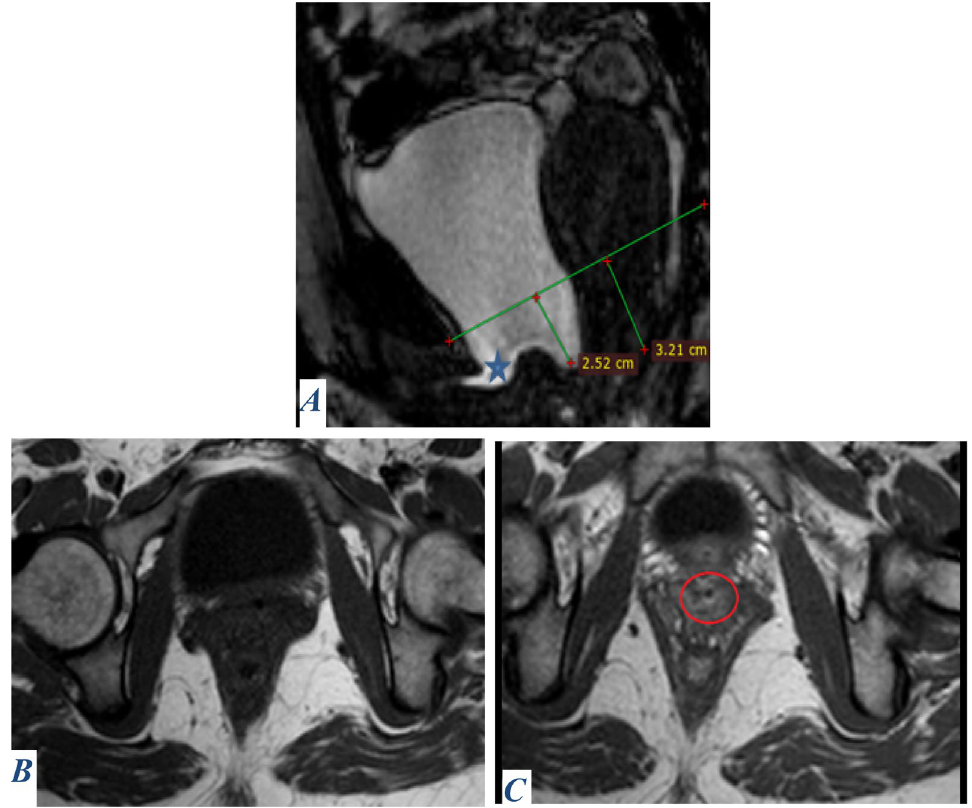
Fig. 7 A 40-year-old female with a history of hysterectomy and SUI, referred after sacrocolpopexy mesh insertion complaining of new pelvic pain, foul vaginal discharge and dyspareunia. Preoperative image: A Sagittal dynamic images showed a cystocele, a peritoneocele (PC) which is an extension of the pouch of Douglas below the upper third of the vagina and maybe containing fluid and rectocele (*). Postoperative images: B , C Axial T2 and post-T1 images showing an area adjacent to right mesh arm of fluid collection and abnormal contrast enhancement (black arrow) complicated right sacrocolpopexy mesh sling with surrounding loculated fluid